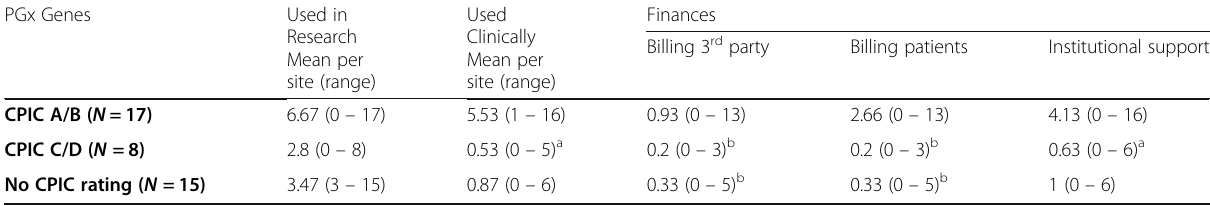
Table 4 CPIC Rating and IGNITE Member Sites ’ use of PGx gene testing for Research, Clinical Reporting and Billing/Reimbursement Methods (range and average number of genes tested) PGx